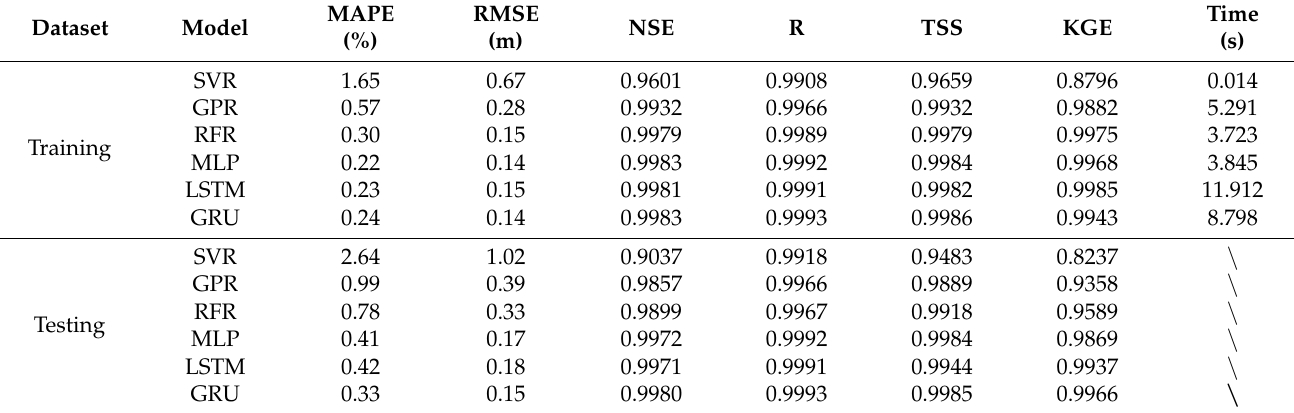
Table 2. Performance of the models for water level hydrograph prediction of Shashi Station.